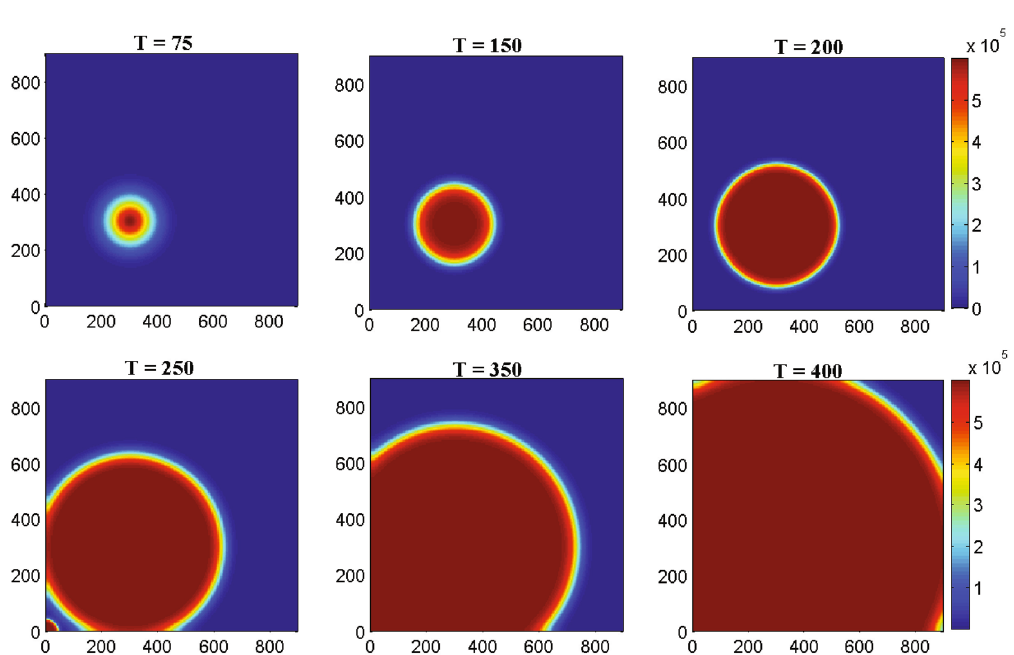
Figure 7. The two-dimensional numerical simulations describe the dynamics of macrophages density M ( t , x , y ) at times corresponding to 75, 150, 200, 250, 350 and 400 h respectively. The simulation demonstrates the spatial distribution of macrophages density through the domain for an increasing value of time. Parameter values: D G = 55 , D M = 5 , D T = 400 , D C = D I = 25 and the other parameter values and initial conditions are presented in the Table